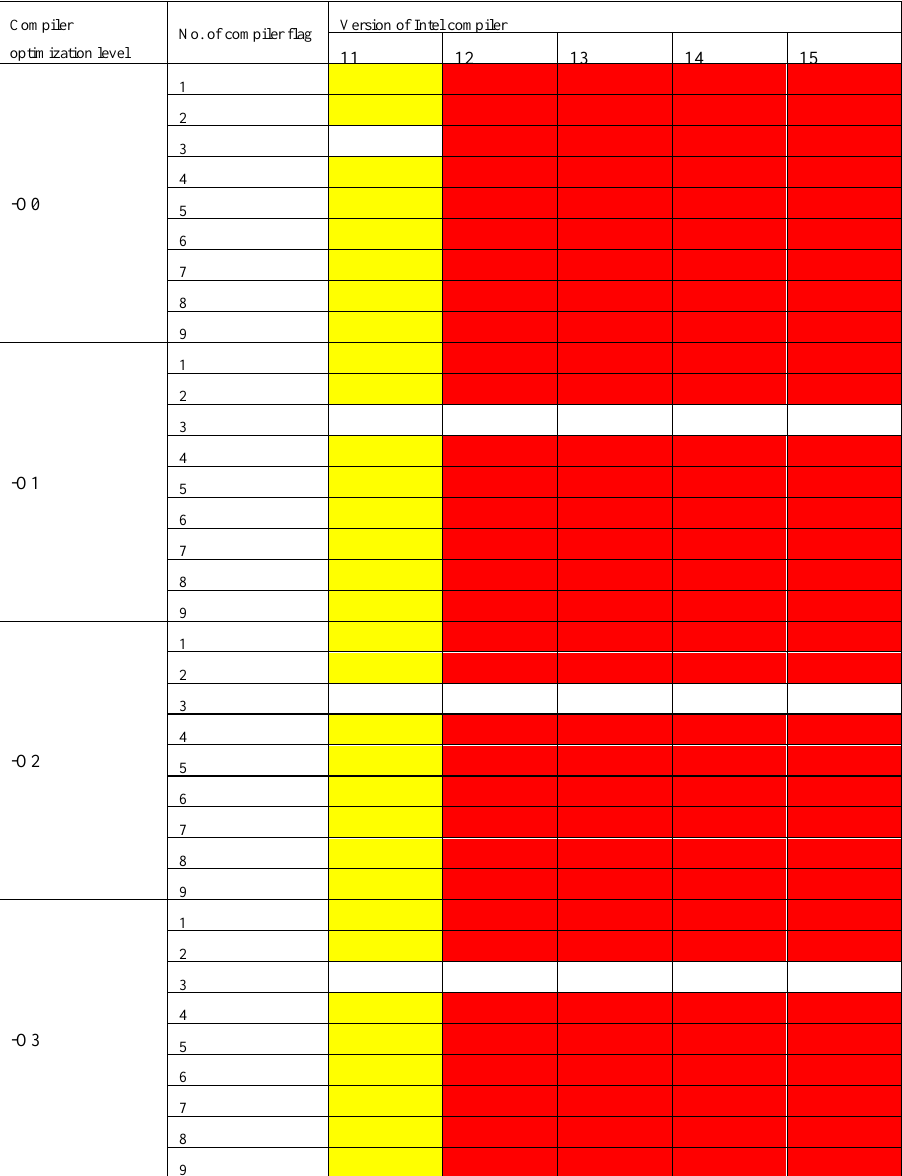
Table 14: Ideal bitwise identical compiling setup sets of the three models when using Intel compilers. Each color except the white corresponds to an ideal bitwise compiling setup set.